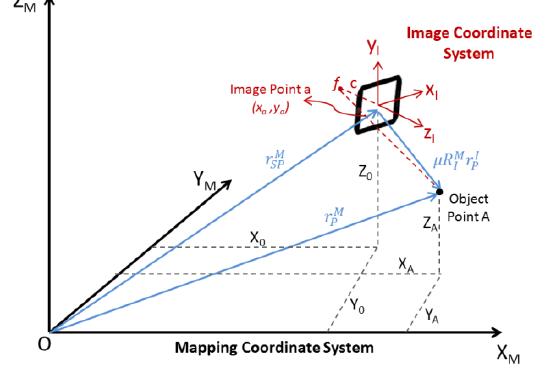
Figure 3. Mapping and Smartphone coordinate systems